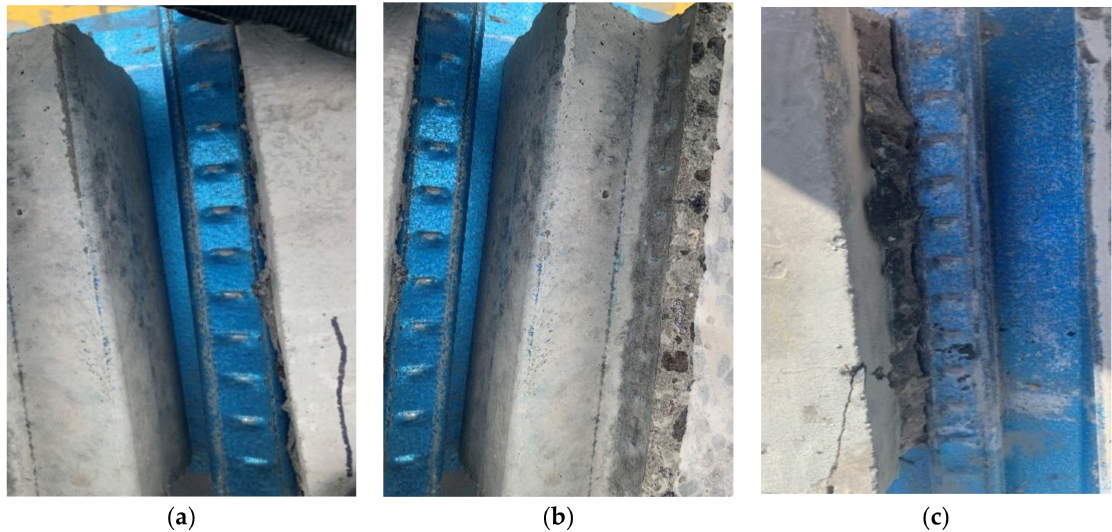
Figure 17. Visual observations around embossments. ( a ) NC40. ( b ) NC60. ( c ) SCGC.